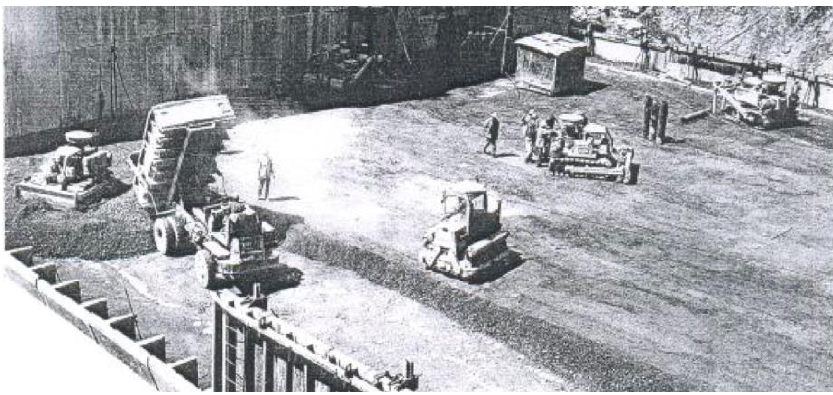
Figure 3. Low-cement concrete laying in the Tashkumyr hydroelectric power station dam. In the late 1980s, the active development of technology began in China. A total of 45 dams were completed there as of 2019. China also has the highest low-cement concrete dam in the world, the Longtan, 217 m high (4.95 million m 3 of in situ concrete), and the 121 m high dam (1.1 million m 3 of low-cement concrete placed).